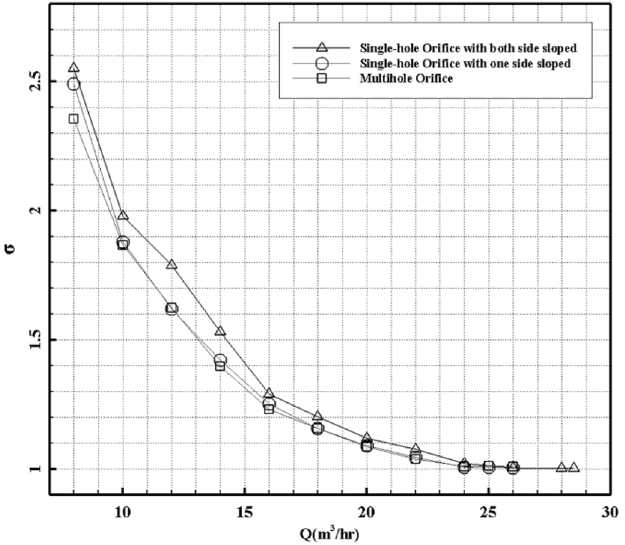
Fig. 13. Comparison of the cavitation number in a multi-hole ori fi ce, a single ­ -hole ori fi ce with a two-sided sloped edge and a single-hole ori fi ce with a one-sided sloped edge.